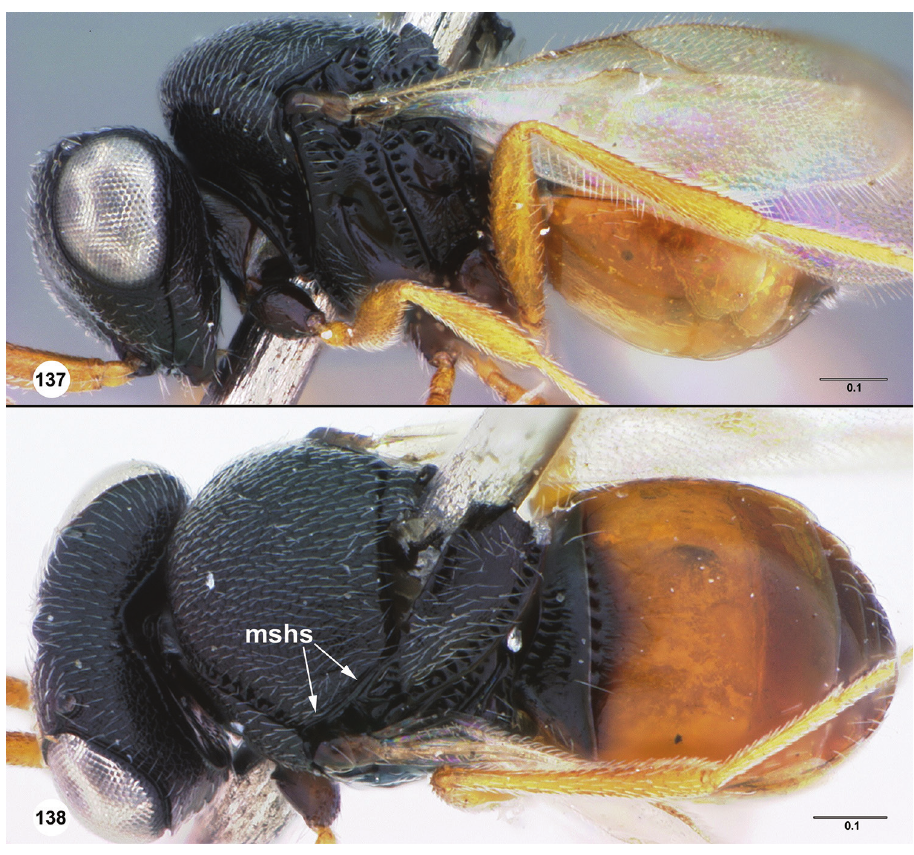
Figures 137–138. T. rufiventris female lectotype (NHMW 0005) 137 head, mesosoma, metasoma, lateral view 138 head, mesosoma, metasoma, dorsal view. Scale bars in millimeters. cutum: absent. Pattern of mesoscutal microsculpture: uniform throughout. Mesoscutal suprahumeral sulcus: comprised of cells. Length of mesoscutal suprahumeral sulcus: about half the length of anterolateral edge of mesoscutum. Parapsidal line: present. Notaulus: absent. Median protuberance on anterior margin of mesoscutellum: absent. Protruberance on anterior margin of mesoscutellum directly posterior to notaulus: pre- sent. Shape of dorsal margin of anterior lobe of axillar crescent: acute. Sculpture of anterior lobe of axillar crescent: uncertain, dorsoventrally strigose. Posterodorsal margin of axillular carina: pointed. Area bounded by axillar crescent: smooth. Macrosculpture of mesoscutellum: absent. Microsculpture on mesoscutellum: present throughout. Me- dian mesoscutellar carina: absent. Form of metascutellum: single row of cells. Metanotal trough: foveate, foveae occupying more than half of metanotal height. Metapostnotum: invaginated near lateral edge of metascutellum. Length of postmarginal vein: about twice as long as stigmal vein. Color of legs: coxae brown, legs elsewhere yellow. Antero- medial portion of metasomal depression: punctate or